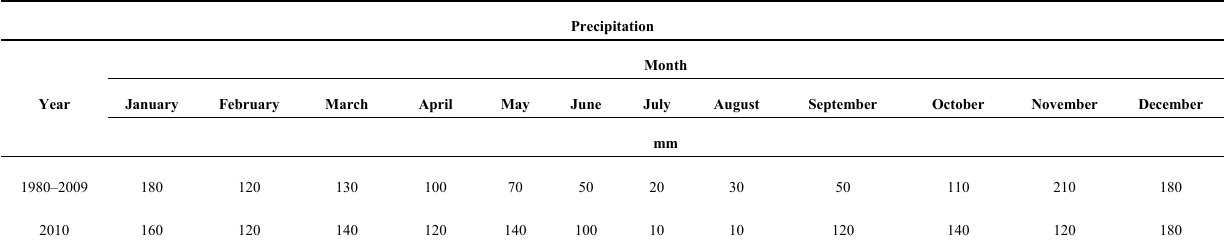
Table 1. Monthly precipitation at the mine site for the first three growing seasons after planting (2010, 2011, and 2012) and previous thirty-year average